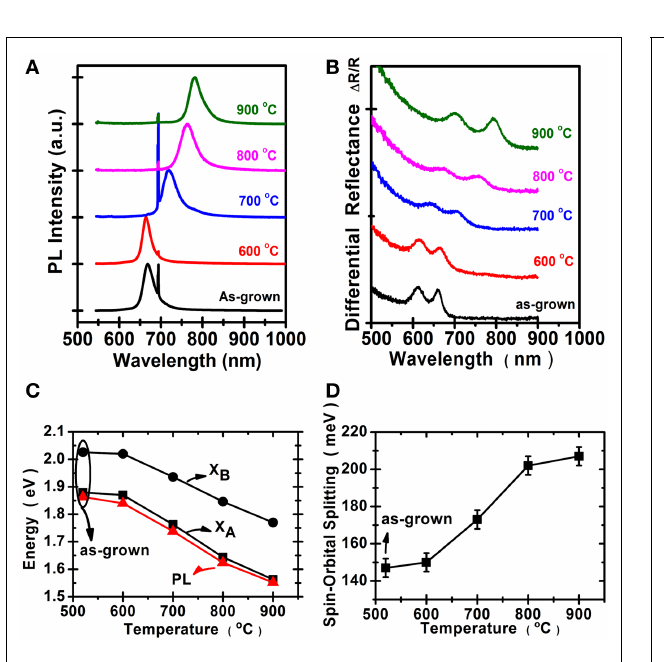
FIGURE 5 | Optical properties of the MoSe 2 are collected before and after sulfurization . (A) Photoluminescence spectra, where the peak at 694nm was from the sapphire substrate. (B) Absorption spectra. (C) The optical energy gap of (A,B) , excitons, and PL peaks. (D) The spin–orbital splitting derived from the absorption